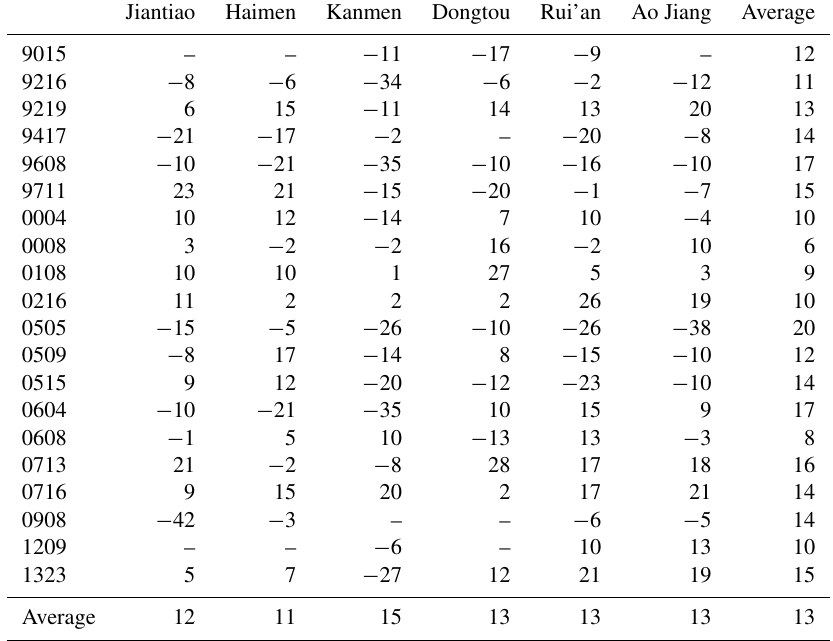
Table 3. Error statistics in terms of the maximum storm surge during landfall of 20 typical typhoons (unit – cm).